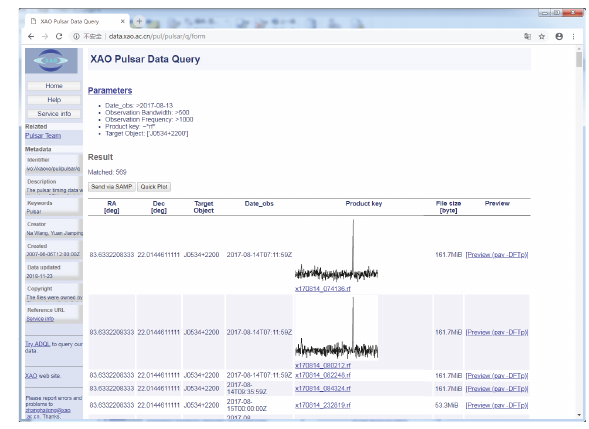
Figure 4: Observational data retrieval results of J0534+2200.